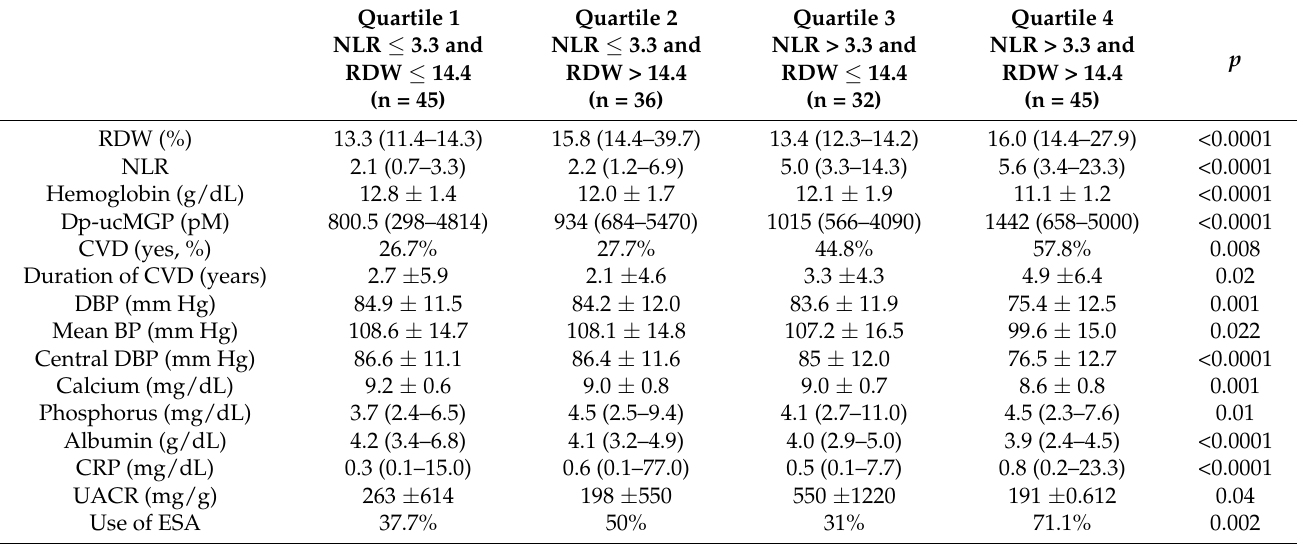
Uncarboxylated Matrix Gla Protein; DBP, Diastolic Blood Pressure; BP, Blood Pressure; CRP, C-reactive protein; UACR, urinary albumin–creatinine ratio; ESA, erythropoietin-stimulating